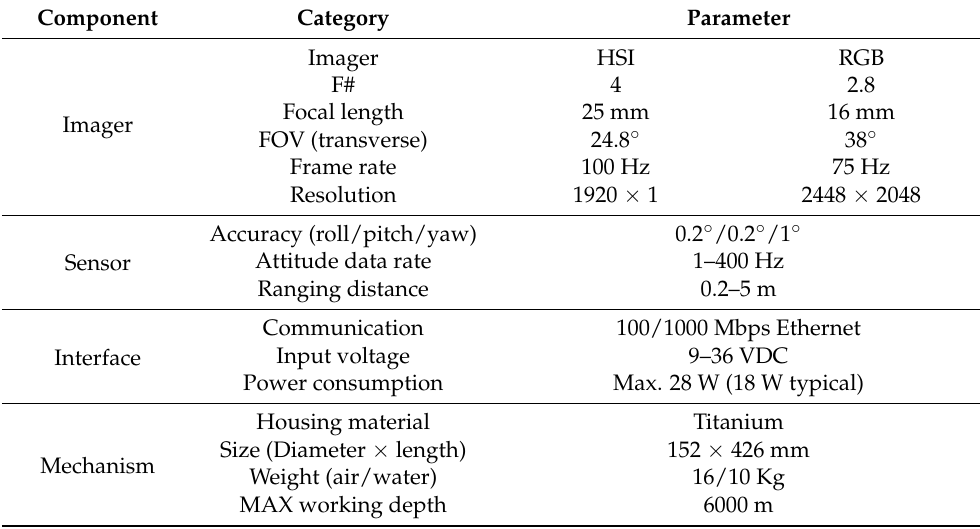
Table 1. The detailed specifications and parameters of our UHI